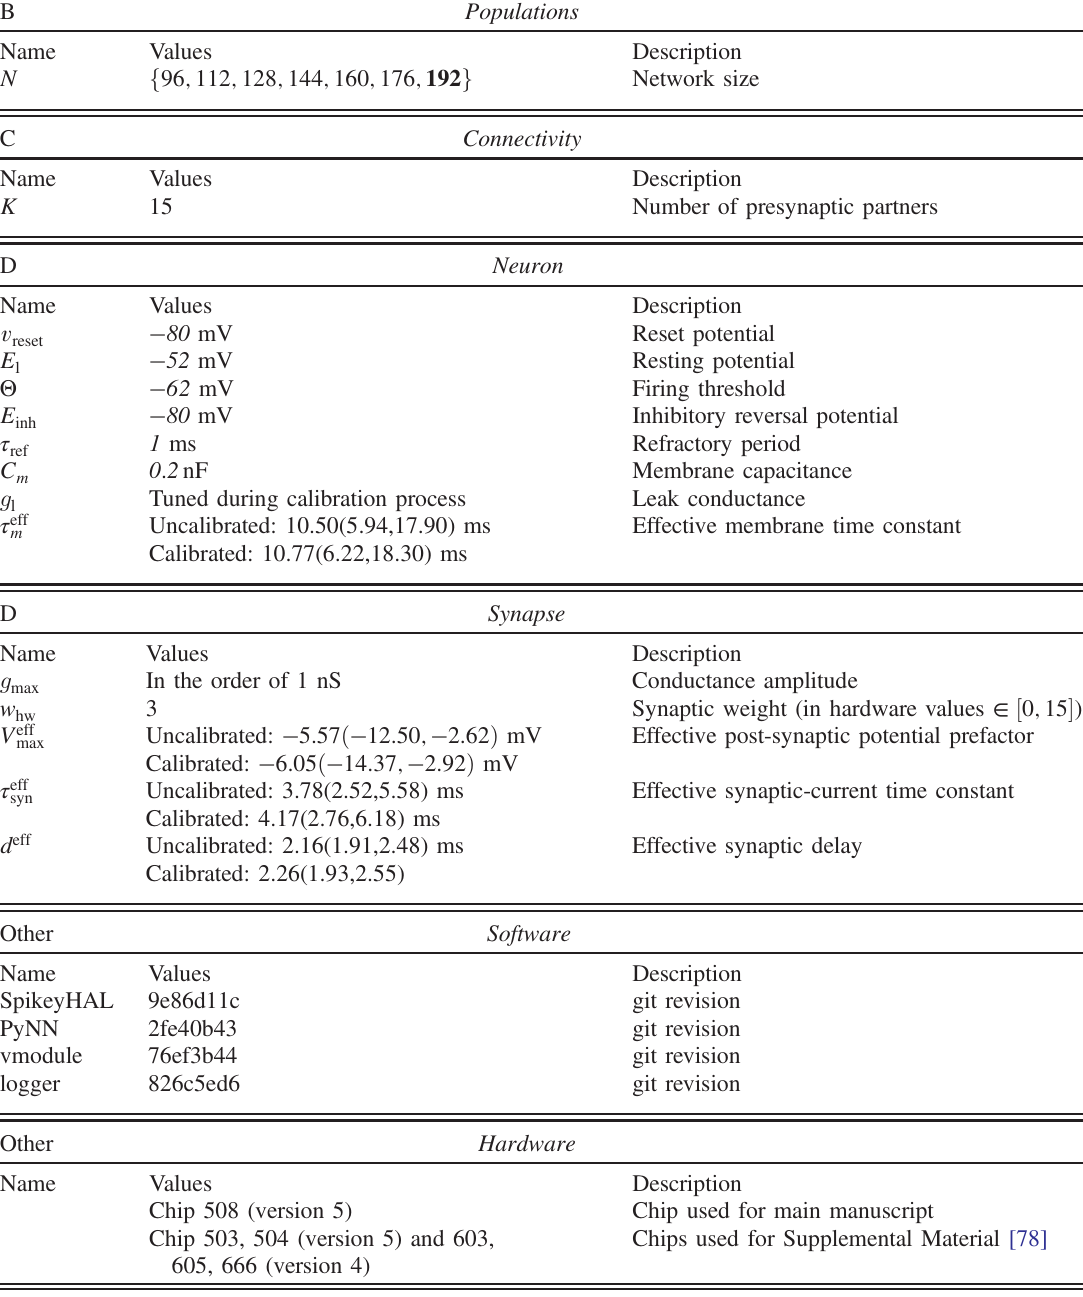
TABLE II. Parameter values for the network model described in Table I. Bold numbers indicate default values. are adjusted in the Italic numbers indicate target values not considering fixed-pattern noise. Leak conductances g l calibration process (see Sec. II E). τ eff , τ eff , d eff , and V eff describe effective values measured from spike-triggered m syn max averages in RAND emulations as described in Supplemental Material, Sec. X. Effective values denote the median across synapses and trials followed by the 25th and 75th percentiles in